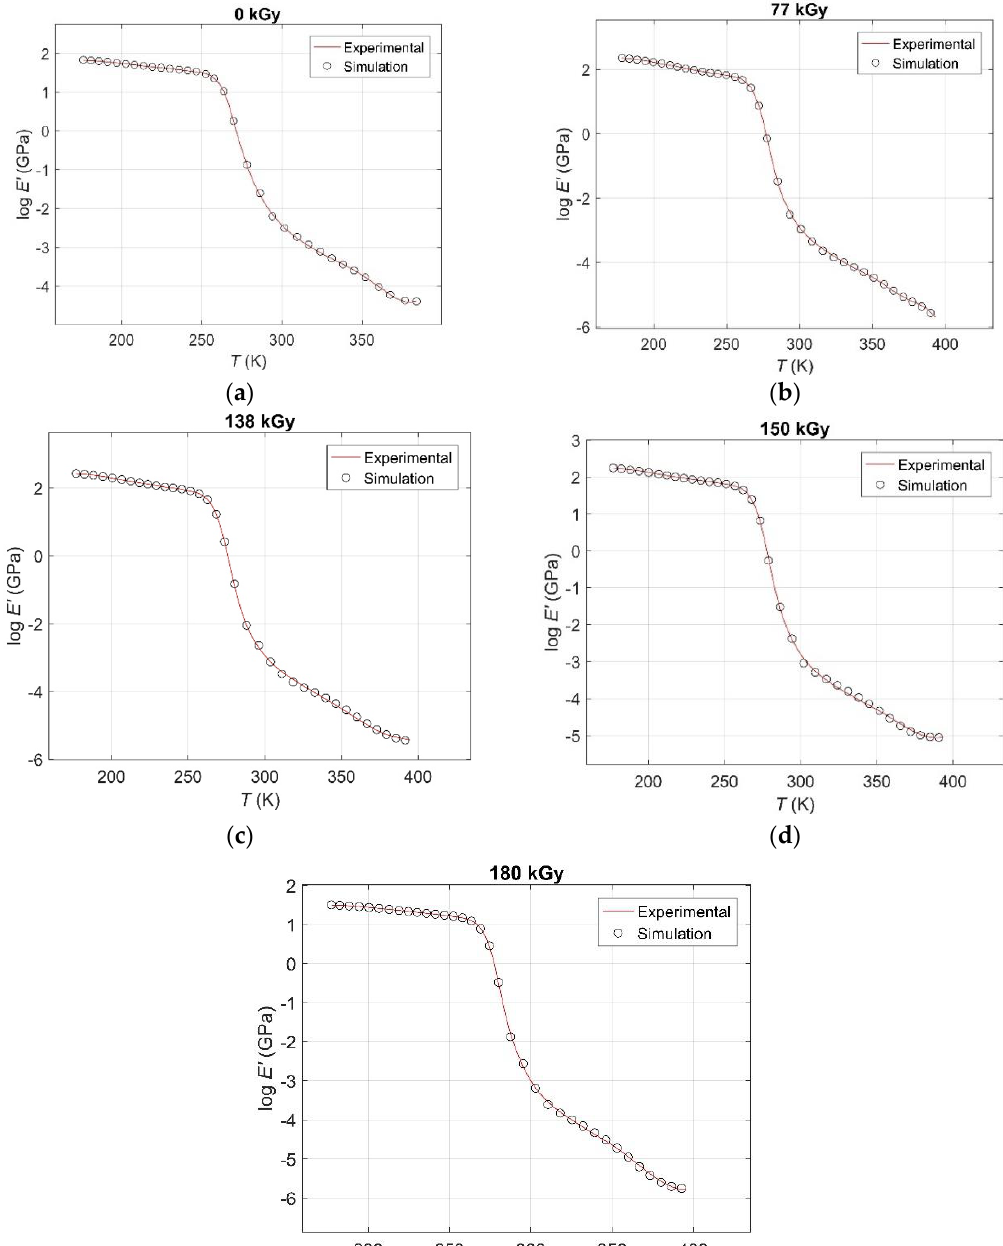
Figure 3. The results of curve fitting by GA compared to the corresponding experimental log( E′ ( T,d )) curves in the temperature range until the onset temperature of the additional thermally-induced polymerisation for: ( a ) an unirradiated sample; ( b ) for a radiation dose of 77 kGy; ( c ) for a radiation dose of 138 kGy; ( d ) for a radiation dose of 150 kGy; ( e ) for a radiation dose of 180 kGy.